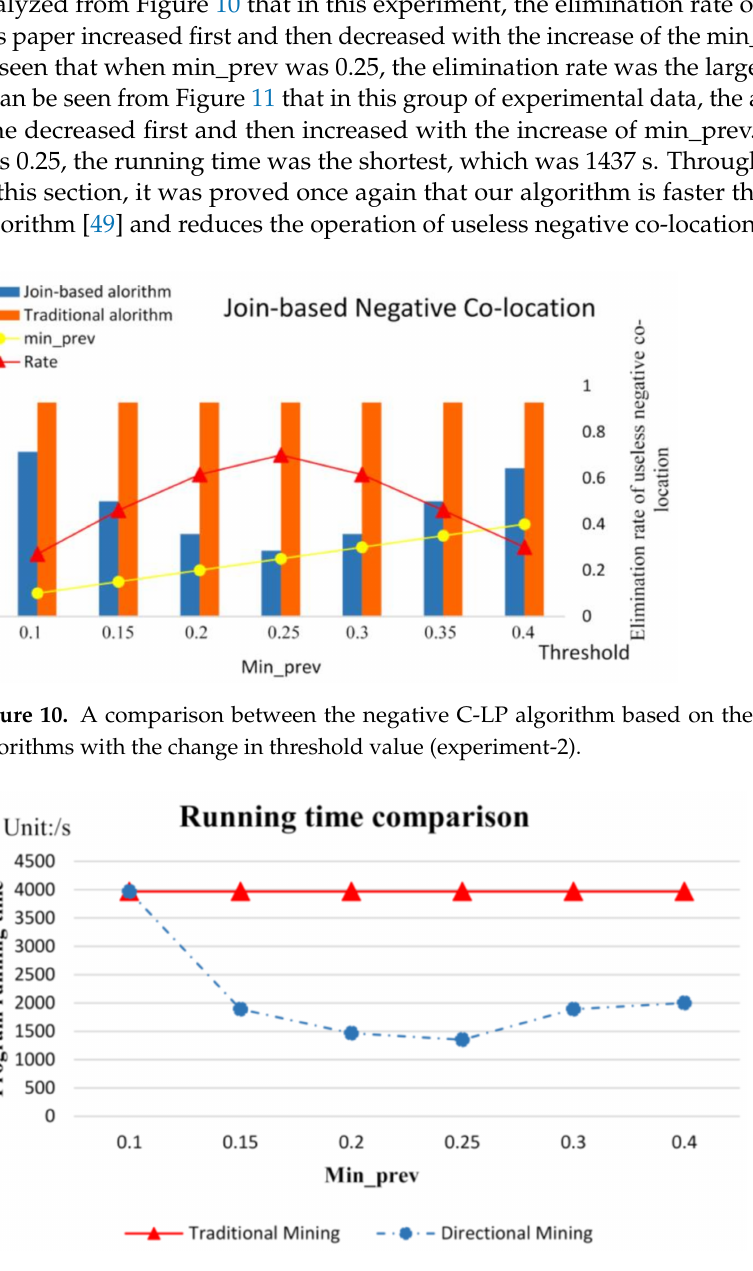
Figure 11. Comparison of running times between traditional mining and directional mining under different